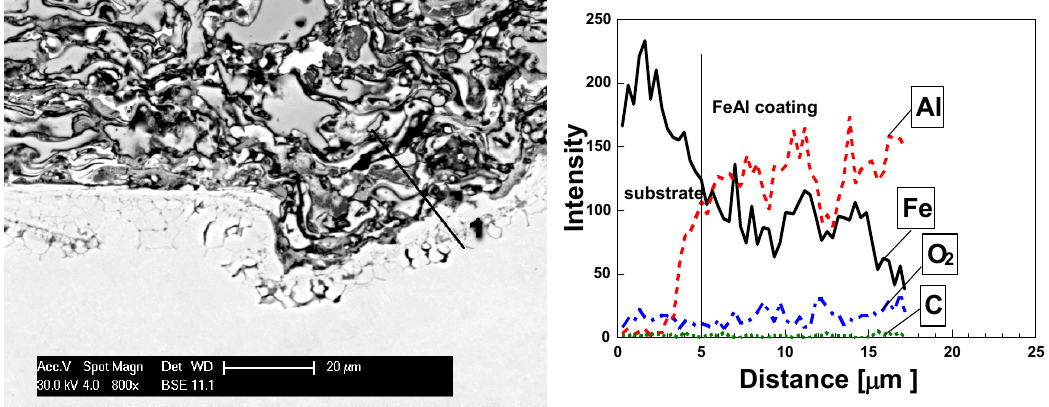
Figure 13. Linear distribution of elements in the FeAl coating after heat treatment at 1100 °C for 10